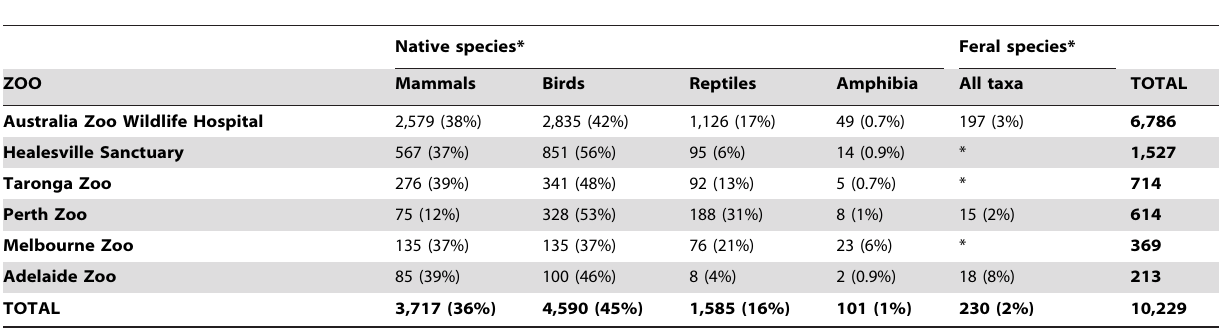
Table 1. Indicative numbers of free-ranging wildlife cases seen by veterinary hospitals at six major Australian zoos over a 12 month period during 2008/2009.